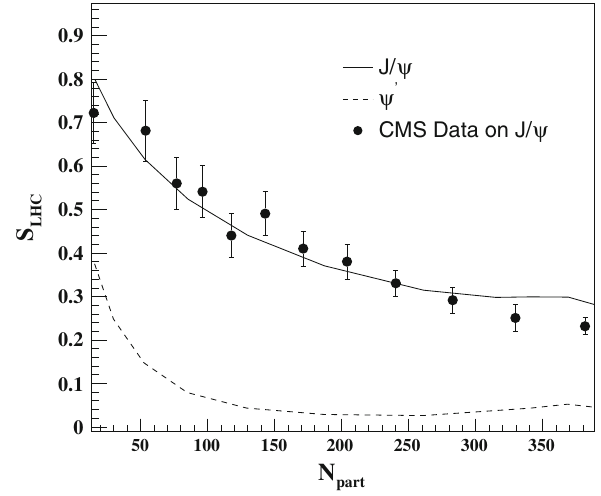
Fig. 21 Variation of survival probability (S) of J /ψ and ψ (cid:8) with respect to N part at center of mass energy mental Data is taken from Refs.